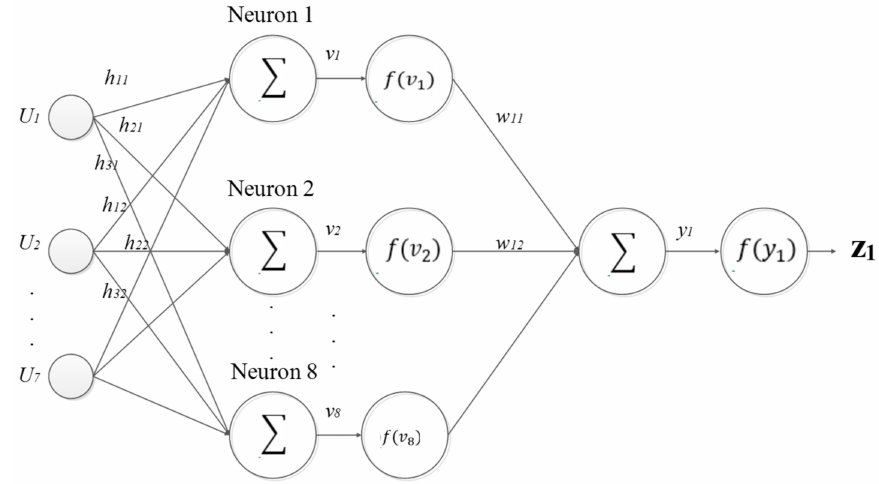
Figure 6. Proposed neural network architecture.